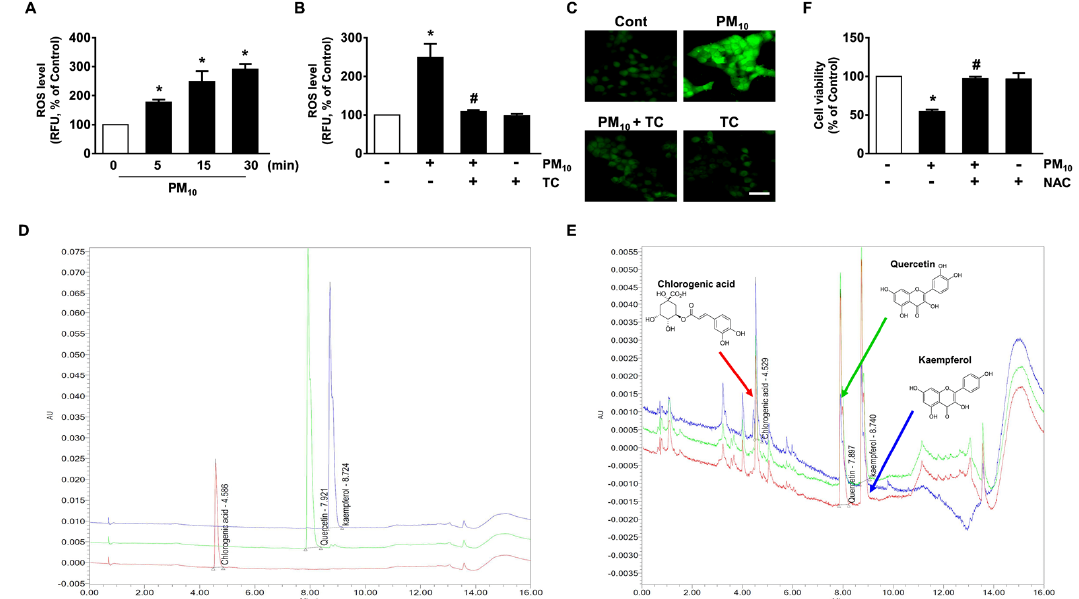
Figure 2. Antioxidative effect of tart cherry containing chlorogenic acid, quercetin, and kaempferol in HaCaT cells treated with PM 10 . ( A ) Time-dependent response of PM 10 (100 μg/mL) on reactive oxygen species (ROS) production determined by staining HaCaT cells with 5-(and-6)-chloromethyl-2′,7′-dichlorodihydrofluorescein diacetate, acetyl ester (CM-H 2 DCFDA). Data are represented as the means ± S.E. n = 3. * p ≤ 0.01 vs. 0 min. ( B ) Cells treated with PM 10 and tart cherry (TC, 200 μg/mL) for 15 min. Data are represented as the means ± S.E. n = 3. * p ≤ 0.01 vs. control. # p ≤ 0.001 vs. PM 10 alone. RFU, Relative fluorescence units. ( C ) ROS production (green) visualized by confocal microscopy. Scale bars, 100 µ m (original magnification × 100). n = 3. ( D ) Ultra performance liquid chromatography (UPLC) profile of the commercial standard compounds. ( E ) UPLC profile of three major compounds in tart cherry. The insets indicate the chemical structure of chlorogenic acid, quercetin, and kaempferol, respectively. ( F ) Cells were pretreated with the antioxidant N -acetylcysteine (NAC, 10 µ M) for 30 min prior exposure to PM 10 for 24 h. Cell viability was determined. Data are represented as the means ± S.E. n = 3. * p ≤ 0.001 vs. control. # p ≤ 0.01 vs. PM 10 alone. Table 2. Contents of the compounds in tart cherry analyzed by UPLC.